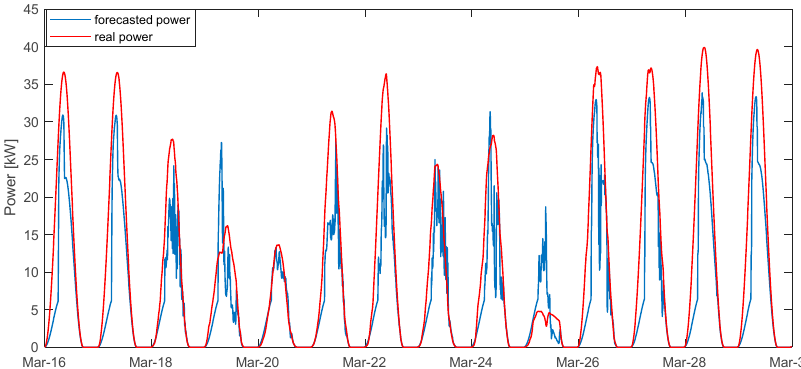
Figure 11. Six hours averaged forecasted PV power with Auto Regressive Mobile Average (ARMA) model.